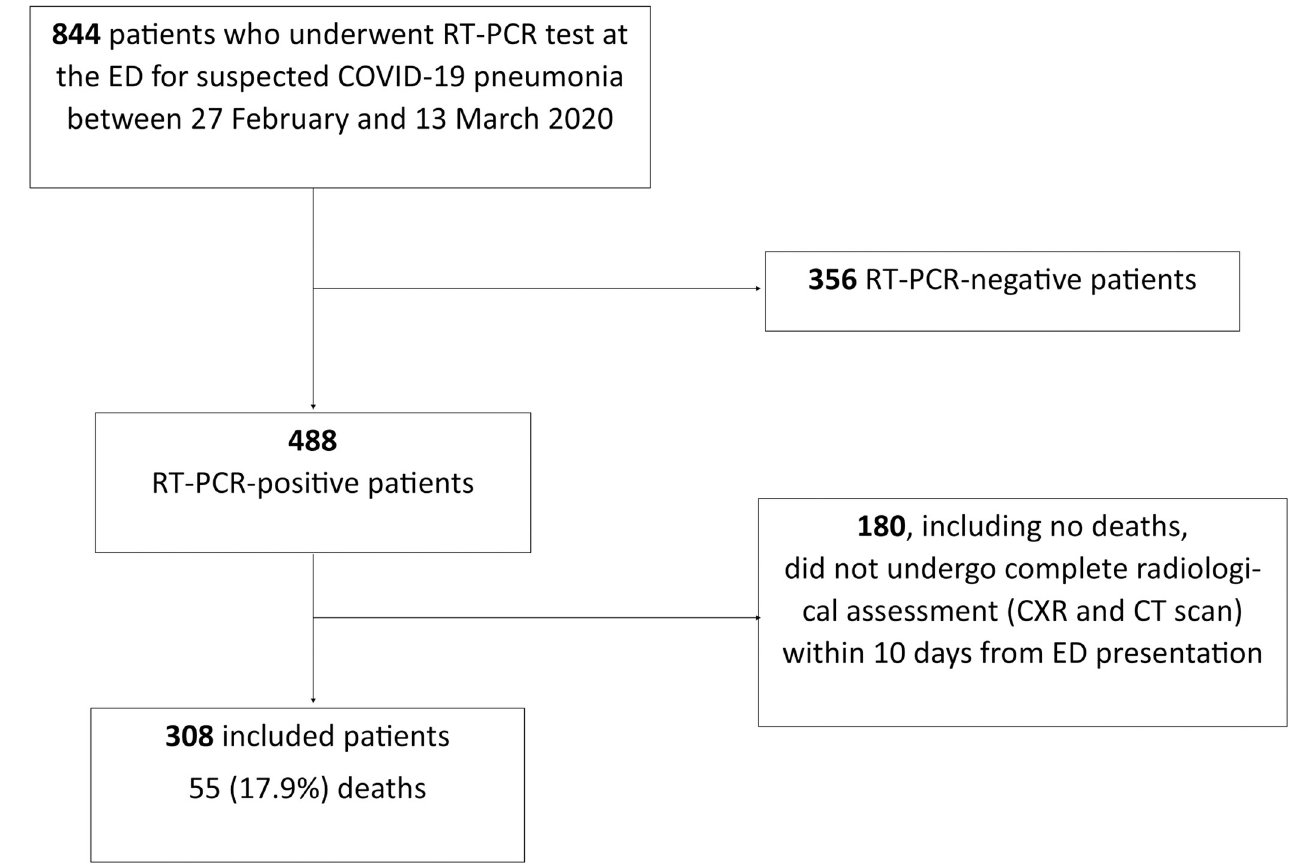
Fig 1. Flowchart representing patient